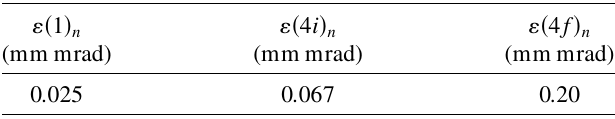
TABLE III. Initial normalized emittance before merging and merged beam emittance from an analytical